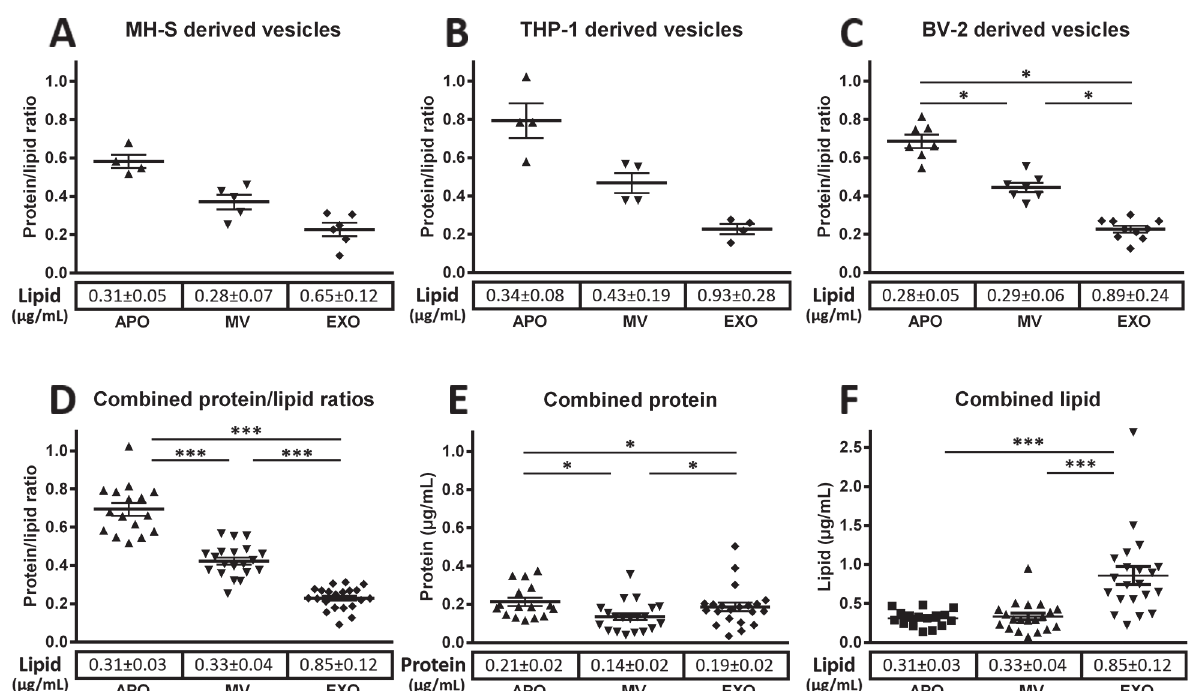
Fig 3. Protein to lipid ratios of EV subpopulations. Protein to lipid ratios are presented for APOs, MVs, and EXOs isolated from MH-S (A), THP-1 (B), and BV-2 (C) cell lines (data represent (cid:3) 3 independent experiments for each EV type from all cell lines). Combined protein to lipid ratios obtained using EVs derived from MH-S, THP-1, BV-2, Jurkat, U937 as well as from human blood plasma are shown (D) (results of (cid:3) 12 independent experiments each EV type). Combined protein (E) and lipid concentrations (F) for the above cell line derived and blood plasma derived EVs are also shown. Mean values are represented by horizontal lines, and standard error means (SEMs) are indicated by error bars. The mean values ± SEM of lipid and protein concentrations ( μ g/mL) of conditioned media are reported below each respective EV subpopulation.